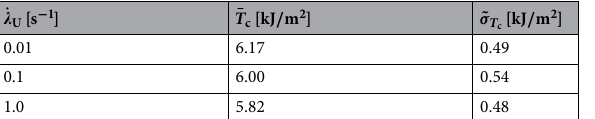
˜ σ T c using the true stored elastic